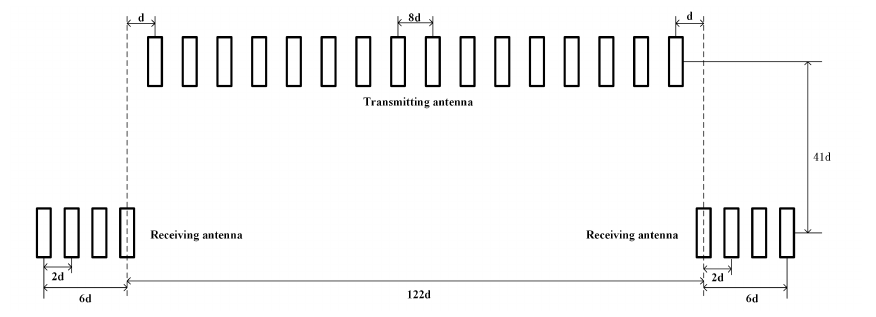
Figure 2. Structure of MIMO-SAR